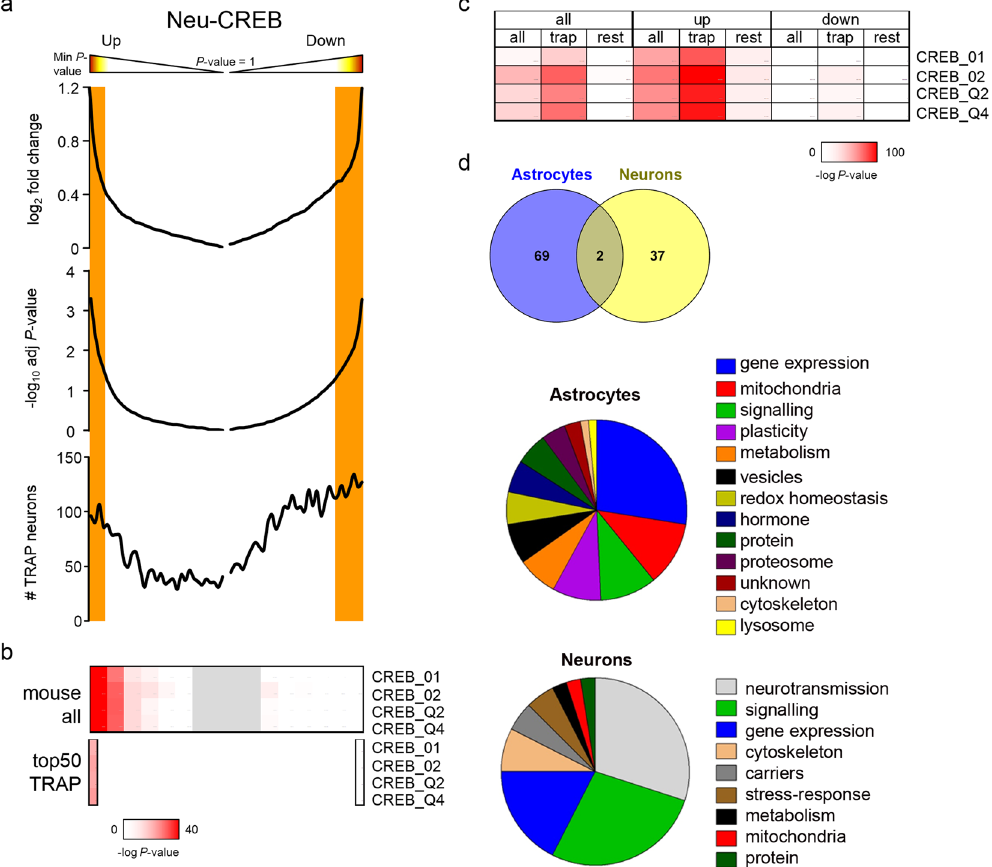
Figure 6. Molecular signatures of CREB in neurons and astrocytes. ( a ) Histograms showing the distribution of genes according to fold change, adjusted p-values, and direction of change (UP or DOWN) in neurons over- expressing VP16-CREB. The whole transcriptome was ranked by the t statistics from more to less significance of change in UP and DOWN sections. Q1-TRAP genes were also mapped below all the transcriptomes, as in Fig. 2. Similar results were observed in the FSK group (not shown). ( b ) PSCAN analysis of CRE-enrichment probability in neurons over-expressing VP16-CREB, using the same procedure as in Fig. 2. CRE-containing genes are enriched in the UP portion, indicating that CREB is mostly a transcriptional activator in neurons. Only the top50 in either UP or DOWN portions were scanned for CRE sites, producing the same bias towards up-regulation. Similar results were observed in the FSK group. ( c ) The same PSCAN analysis without considering bins but entire sets of genes: ‘all’, all the genes; ‘up’ and ‘down’, all the up-regulated and down- regulated genes independently of the significance of change; ‘TRAP’, only the Q1-TRAP list; ‘rest’, the remaining genes. The up-regulated Q1-TRAP genes were enriched in CRE sites. ( d ) Core up-regulated astrocyte genes filtered through the Q1-TRAP list and the CREB-target-gene database (Salk institute) were compared with neuronal databases obtained from neurons treated with FSK or VP16-CREB 10 processed in like manner. Venn diagrams showed almost no overlapping between both cell types. Categories were manually inferred from gene function according to the literature. The full lists are in Supplementary data S4. Chart slices correspond to the percentage of genes in each